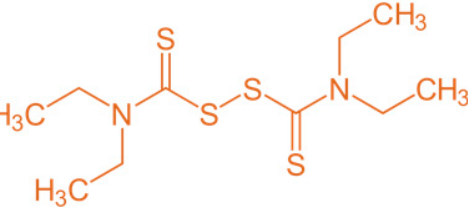
Figure 1. Chemical structure of disulfiram molecule (D).